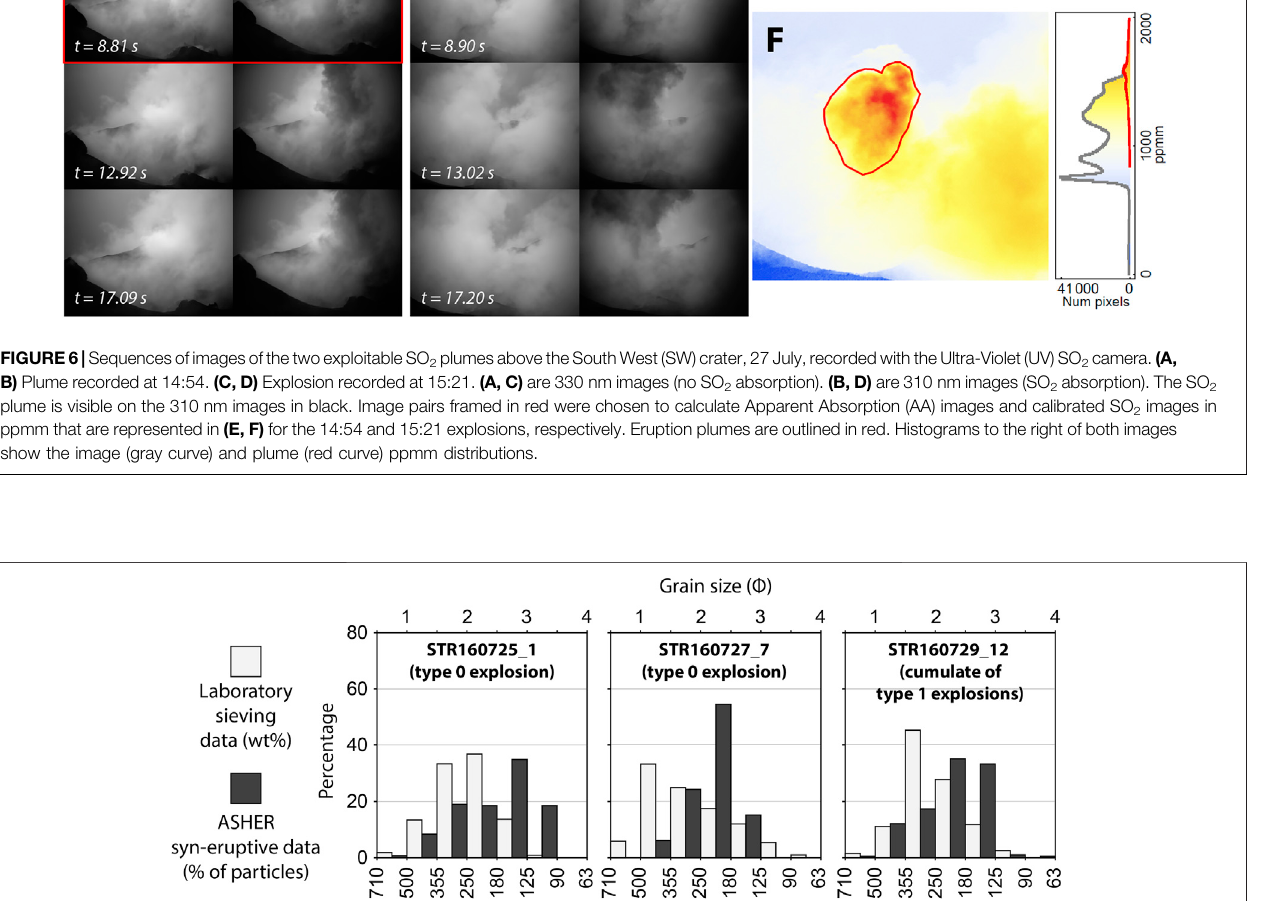
Frontiers in Earth Science |